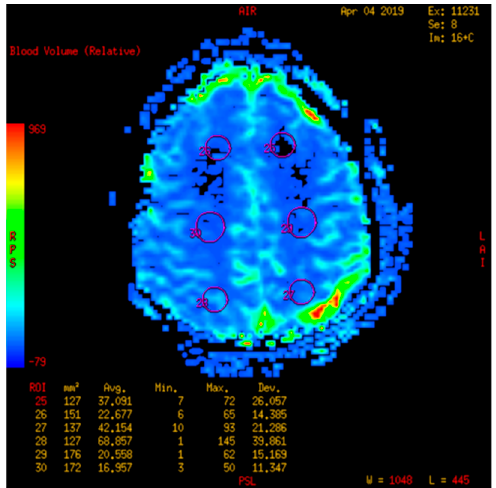
Figure 2. PWI of patients with TND in the perioperative period after operation (example 2). ( a , b ) The PWI images of the patients 5 days before operation showed that the cerebral blood flow (CBF) and cerebral blood volume (CBV) of the bilateral hemispheres were basically the same. ( c , d ) 3 days after the left combined operation, the patients showed blurred vision and dizziness. 6 days after operation, the PWI images showed that the CBF and CBV of the left parietal occipital lobe were significantly higher than those of the opposite side. Table 4. The univariate analysis of perioperative complications after revascularization in 203